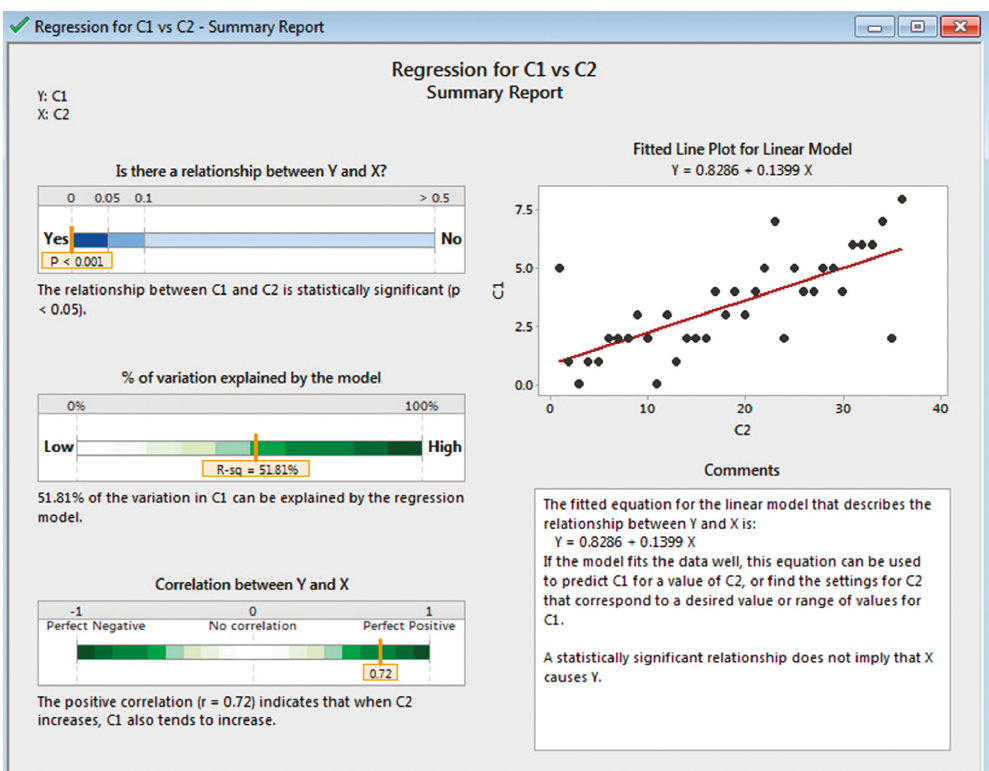
Figure 2: Correlation diagram of customer